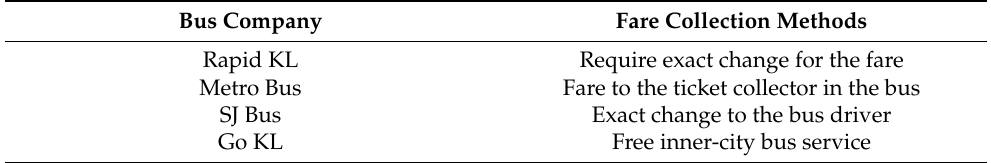
Table 2. Bus companies and fare collection methods in KL, Malaysia.